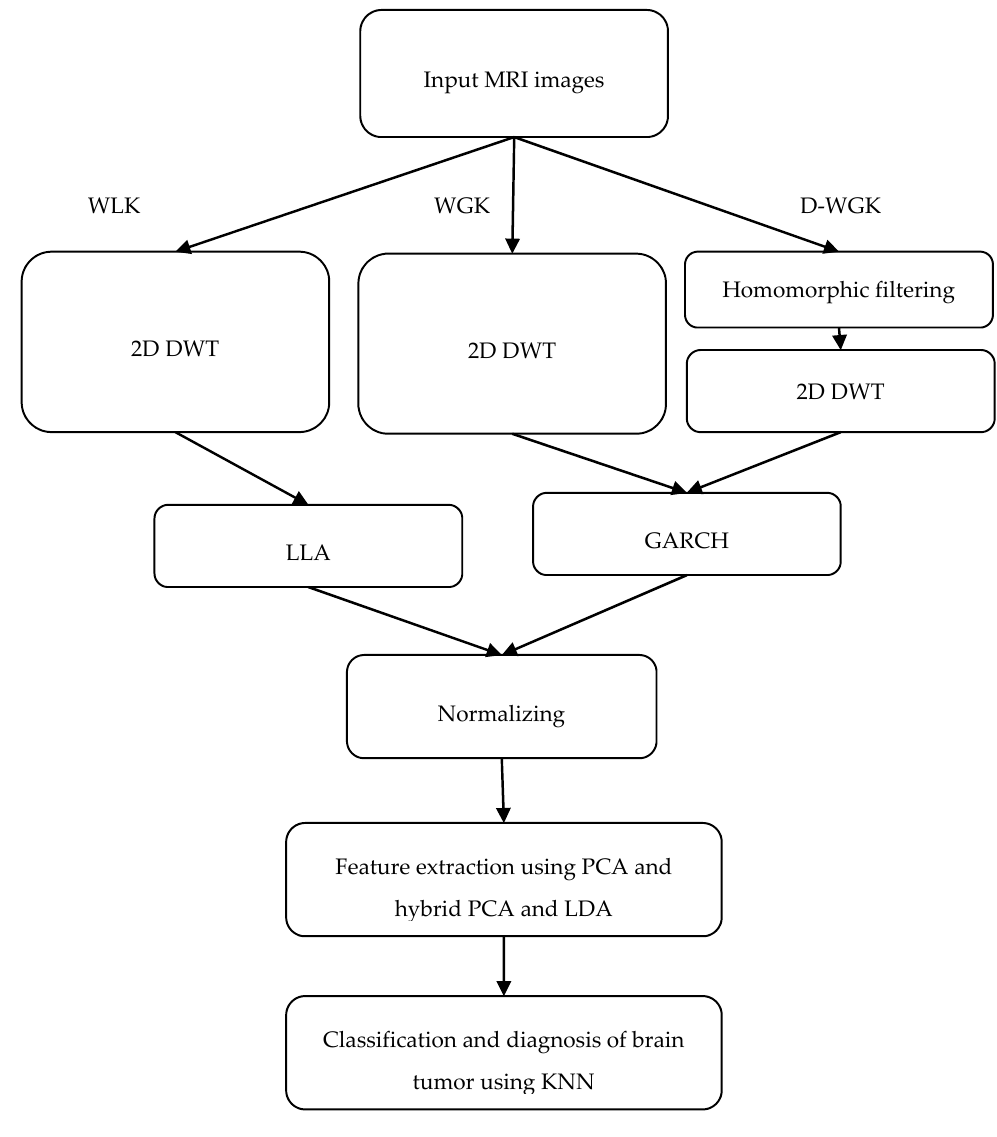
Figure 2. The block diagram of the proposed method.